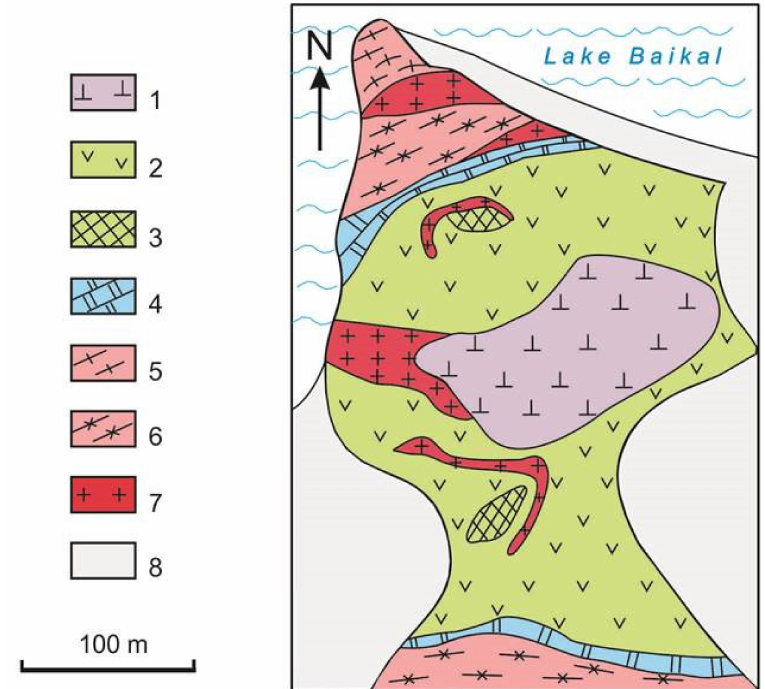
Figure 5. Geological map of Bayar peridotite. 1 = dunite and harzburgite; 2 = amphibolite; 3 = garnet amphibolite and garnet–anorthite–fassaite rocks; 4 = calcite–dolomite marble; 5 = biotite and garnet–biotite gneisses; 6 = gneissic granite; 7 = pegmatite; 8 = quaternary